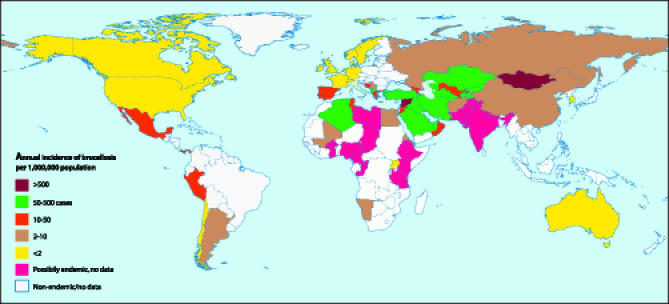
The Global Endemicity of BrucellosisDerived from [7].